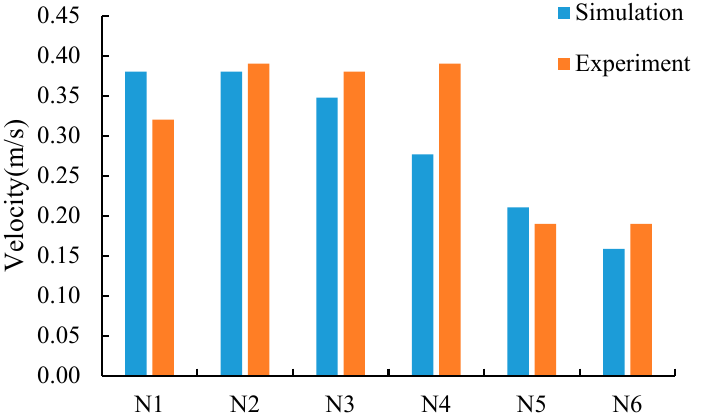
Figure 10. Comparison between the simulation values and experiment values of the air velocity in the ventilation duct. Table 3. Comparison between the simulation values and experiment values of the air velocity in the ventilation duct.